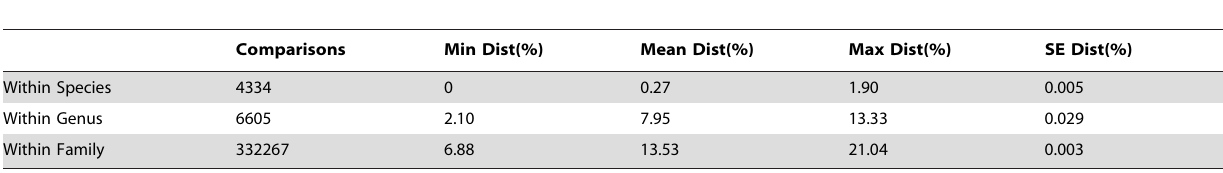
Table 2. Genetic distances (K2P) for the barcode region of the COI gene for 113 species of Nymphalidae from the Yucatan